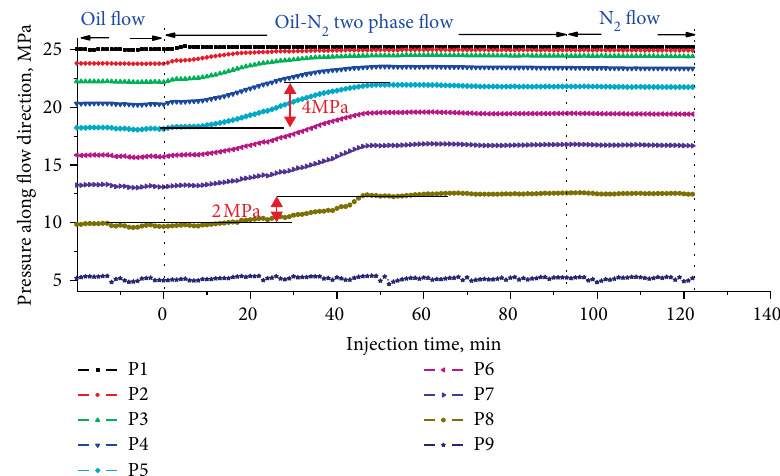
Figure 13: The N flooding results in tight oil 2